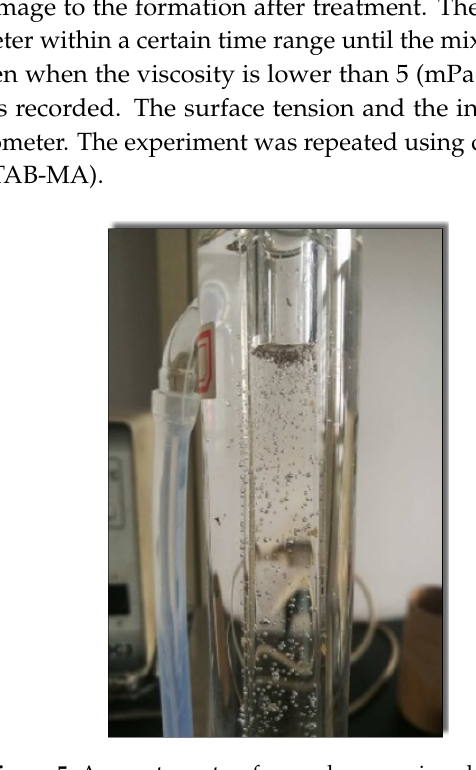
Figure 5. Apparatus setup for sand suspension ability